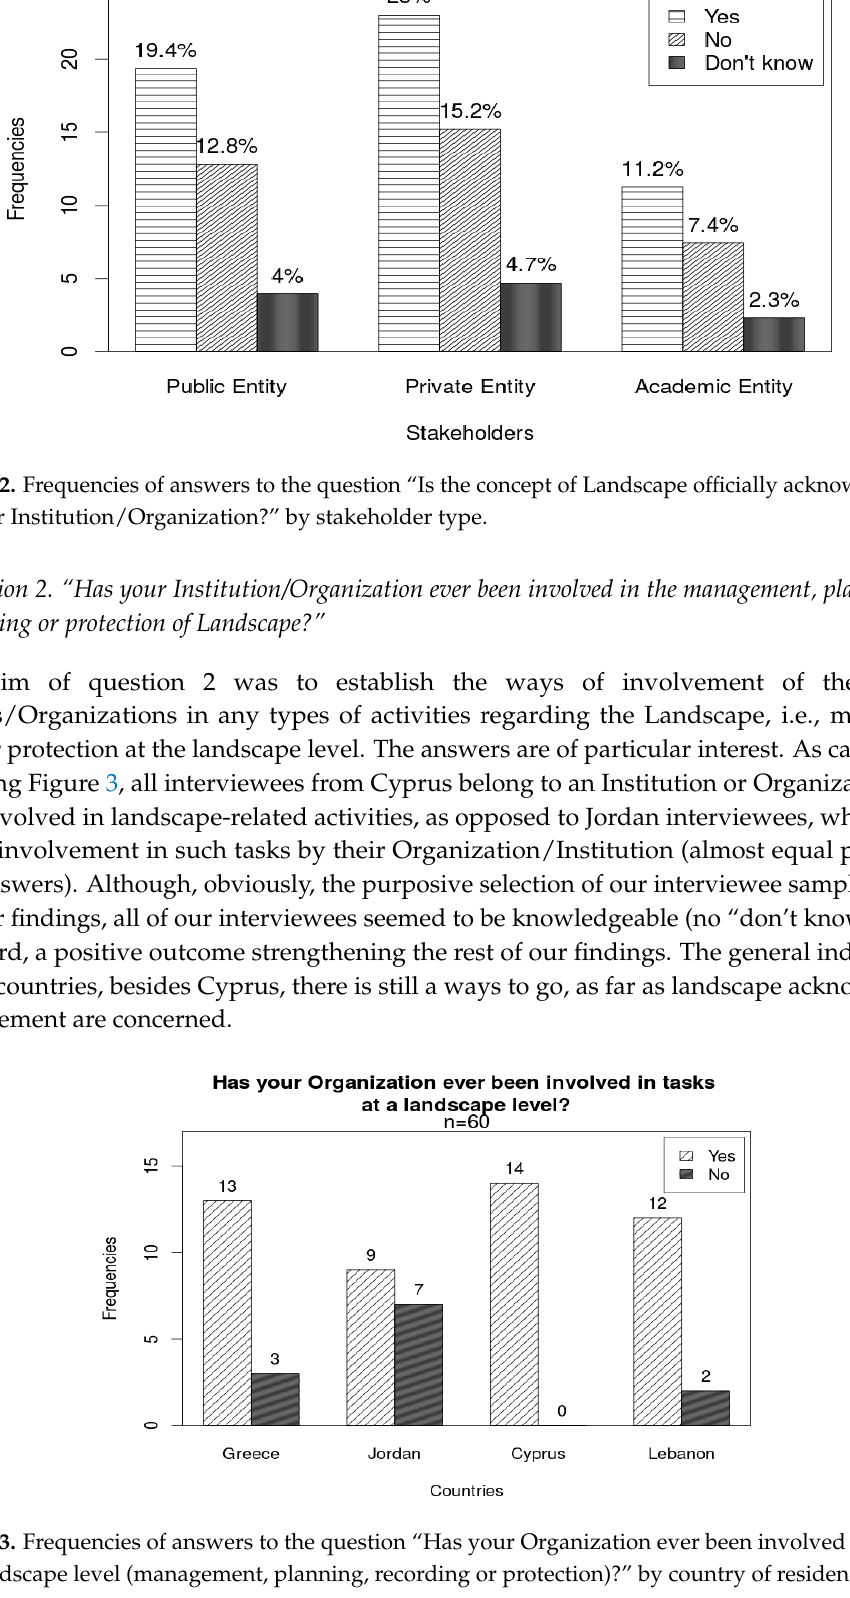
Figure 1. Frequencies of answers to the question “Is the concept of Landscape officially acknowledged by your Institution/Organization?” by country of residence.